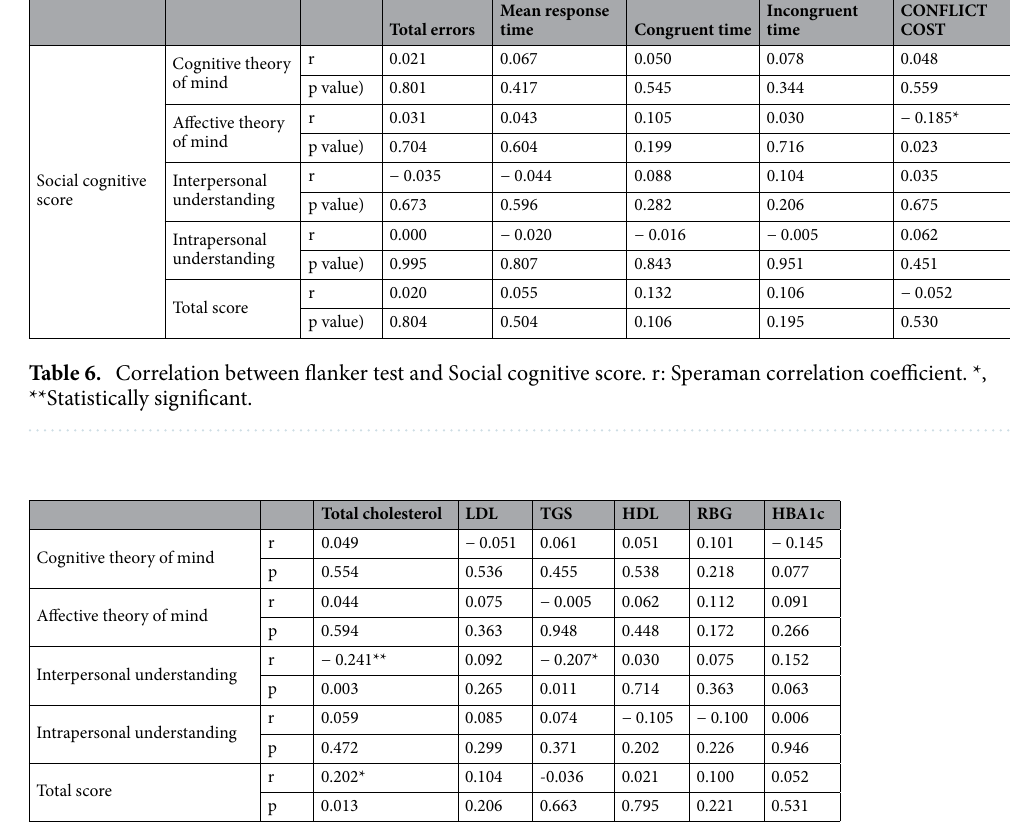
Table 7. Correlation between metabolic profile and social cognitive functions in the cases group: LDL low density lipoprotein = Triglycerides, HDL high density lipoprotein, RBG random blood glucose, HBA1c hemoglobin A1C.